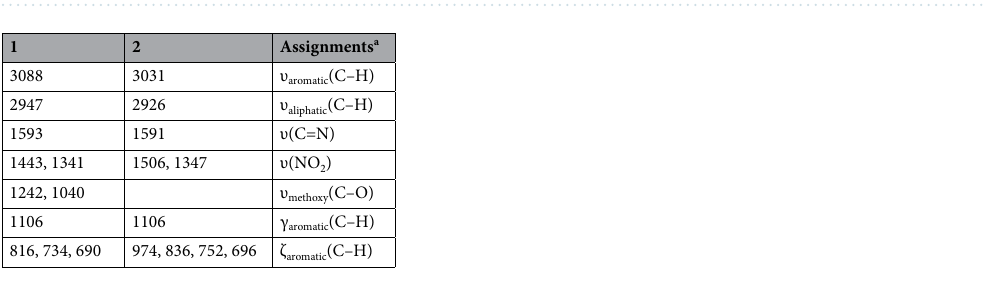
Table 4. FT-IR Spectral assignments. a υ: stretching, γ: bending, ζ: out of plane